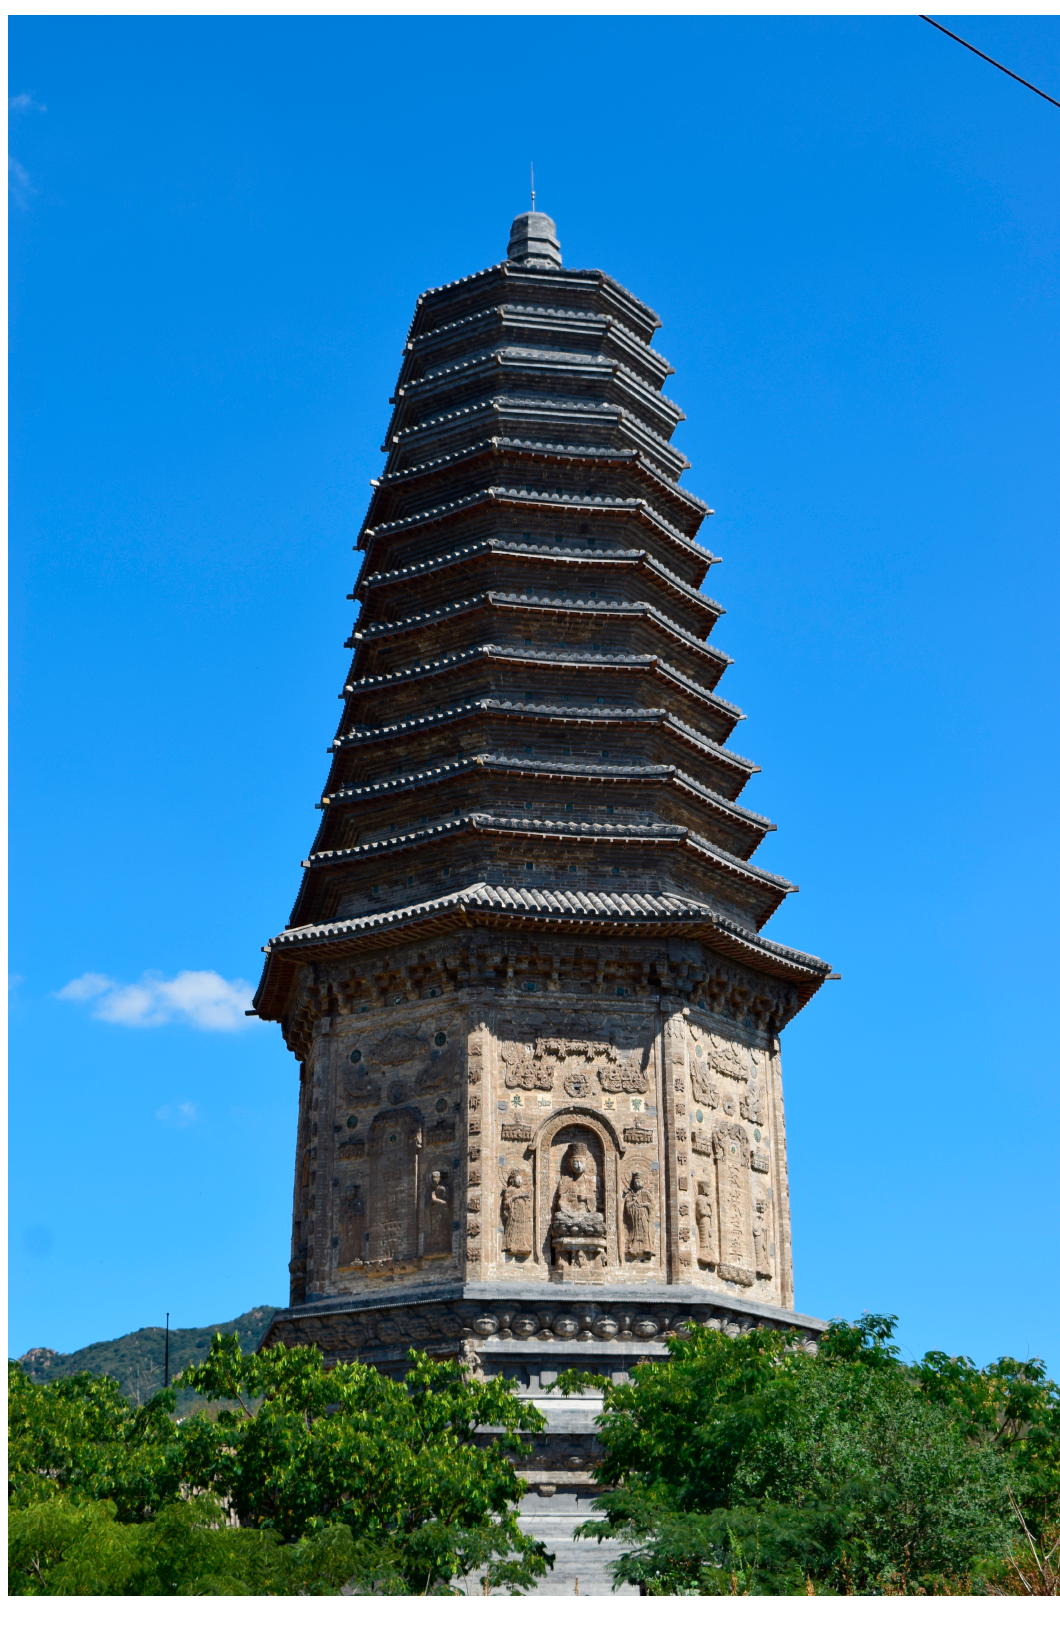
Figure 6. Baitayu Pagoda, Xingcheng, Liaoning Province. Liao dynasty, 1092 [©Photograph by Youn-mi Kim, 2014].